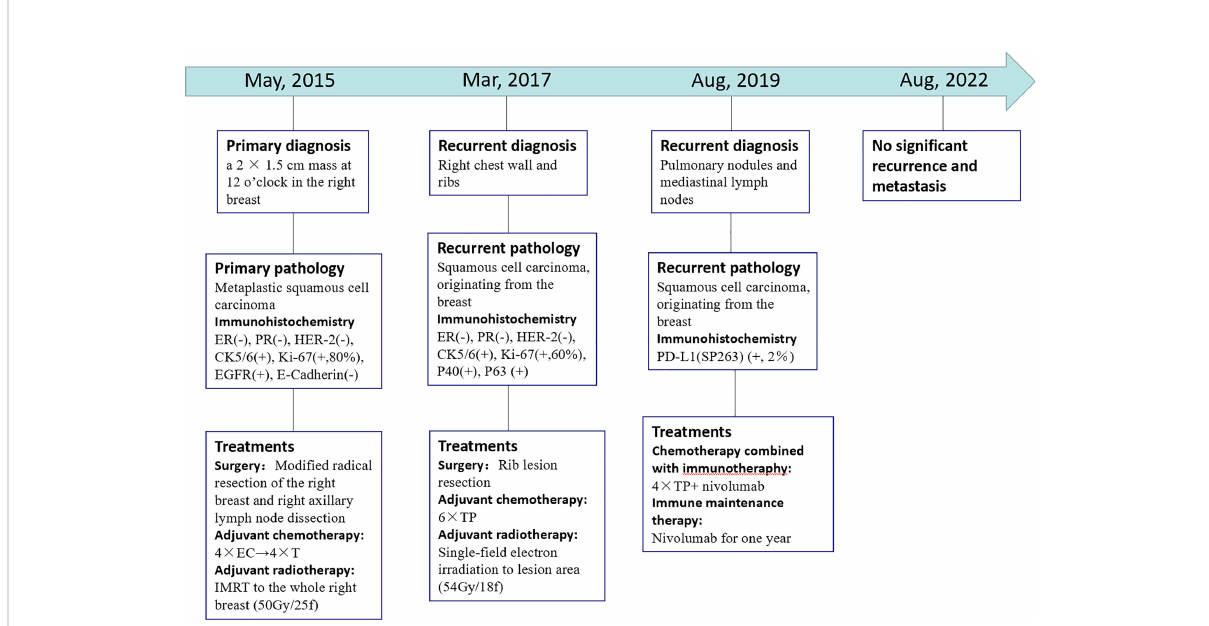
FIGURE 3 Timeline showcasing relevant data from the episode of care. ( – ): Negative expression; (+): Positive expression. 4 × EC ! 4 × T: four cycles chemotherapy of epirubicin and cyclophosphamide followed by four cycles of docetaxel. IMRT: intensity modulated radiotherapy. 6 × TP: Six cycles chemotherapy of liposomal paclitaxel and carboplatin. 4 x TP + nivolumab: four cycles chemotherapy of albumin paclitaxel plus cisplatin combined with